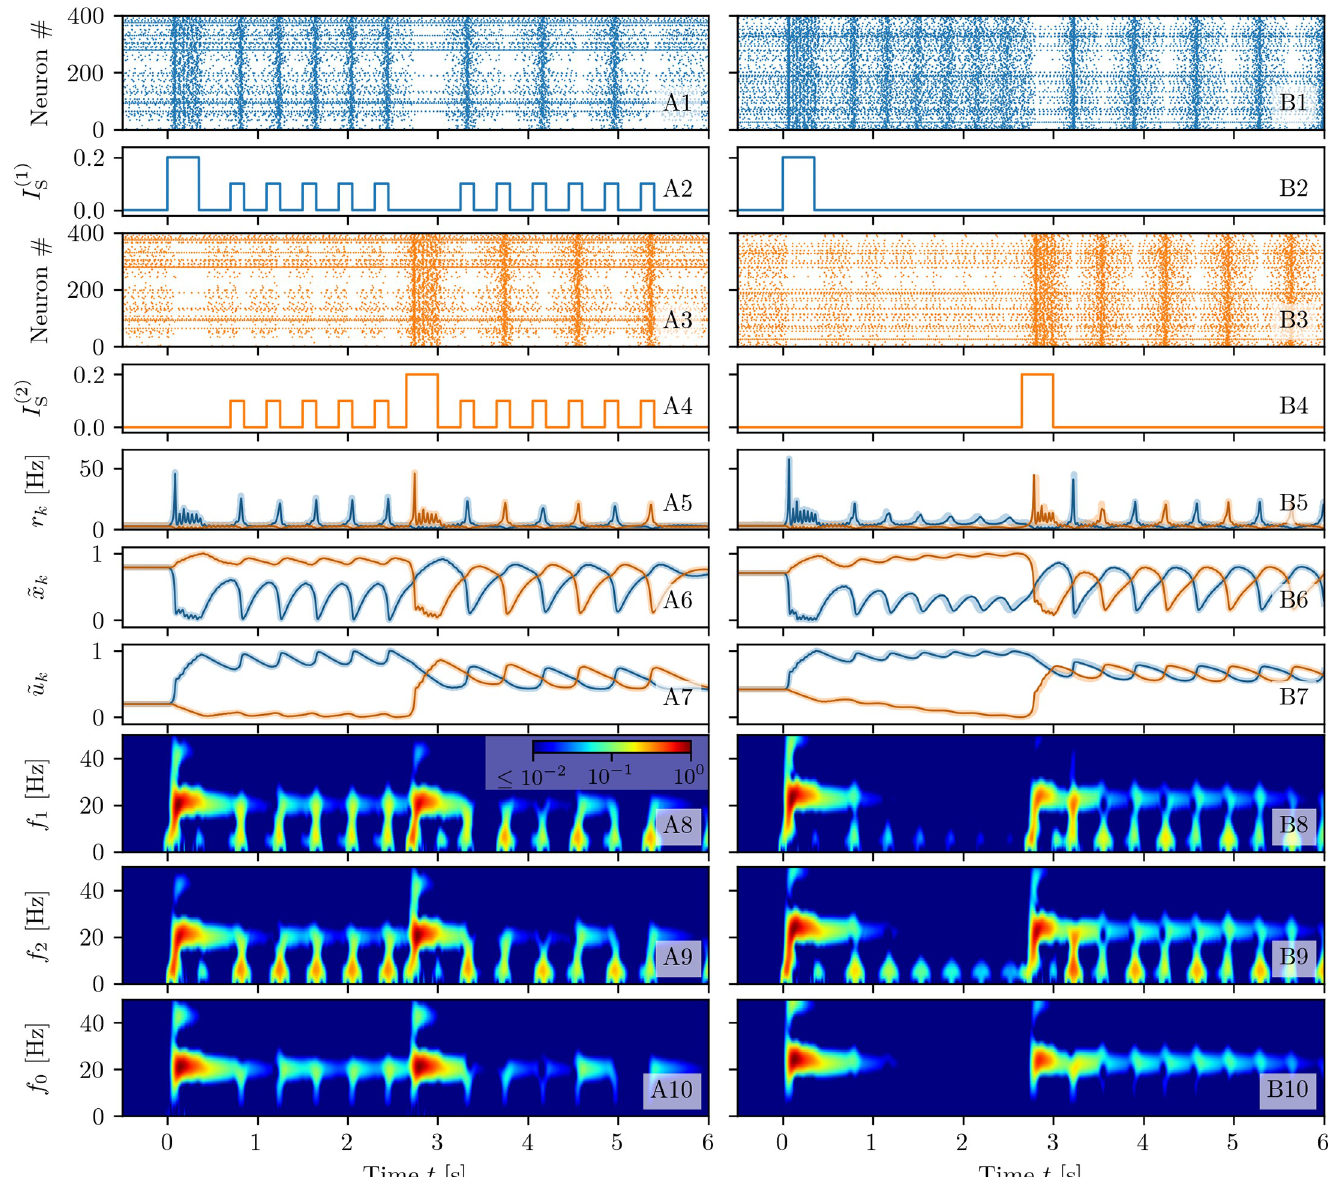
Fig 5. Juggling between two memory items. The memory juggling is obtained in two experiments with different background currents: in presence of a periodic unspecific stimulation ( I B = 1.2, A) and in the case of spontaneous WM reactivation ( I B = 1.532, B). Raster plots of the network activity for the first (blue, A1-B1 ) and ð t Þ for the first ( A2-B2 ) (second ( A4-B4 ))) excitatory population. Population second (orange, A3-B3 ) excitatory population. Profiles of the stimulation current I ð k Þ S firing rates r k (t) ( A5-B5 ), normalized available resources ~ x ð t Þ ( A6-B6 ) and normalized utilization factors ~ u ð t Þ ( A7-B7 ) of the excitatory populations calculated from k k the simulations of the neural mass model (solid line) and of the network (shading). Spectrograms of the mean membrane potentials v 1 ( t ) ( A8-B8 ), v 2 ( t ) ( A9-B9 ), and v 0 ( t ) ( A10-B10 ) obtained from the neural mass model. All the other parameter values as in Fig 3.